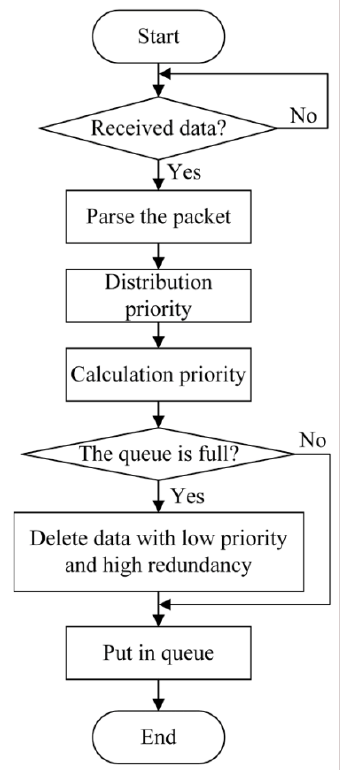
Figure 5. Data frame priority queue queuing